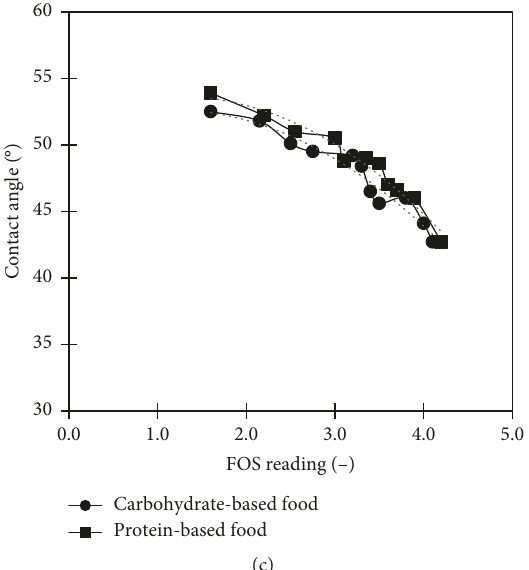
Figure 7: Scatter plots and regression lines of contact angle (CA) of frying oil in relation to (a) FFA, (b) TPMs, and (c) FOS